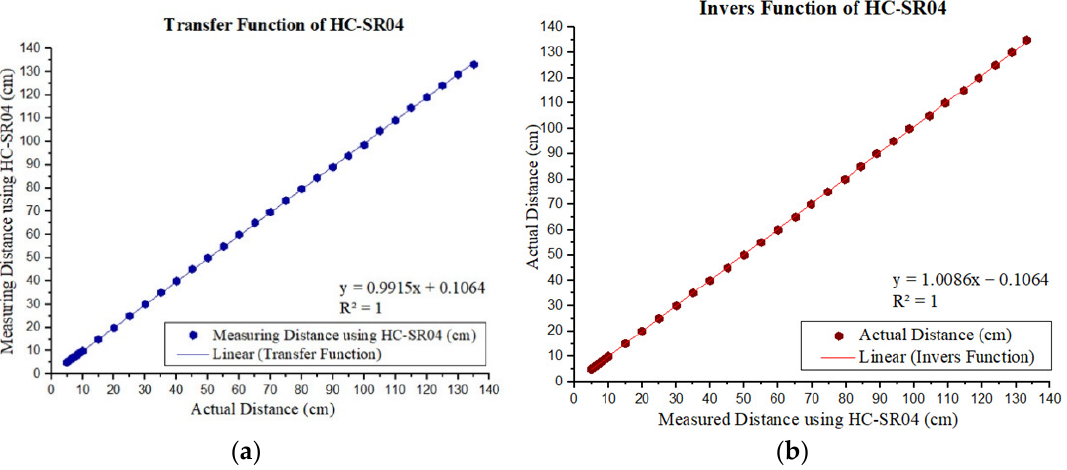
Figure 7. ( a ) HC-SR04 sensor transfer function for height measurement. The slope value on the graph indicates that the sensor has a sensitivity value of 0.991; and ( b ) HC-SR04 sensor invers function for height measurement.